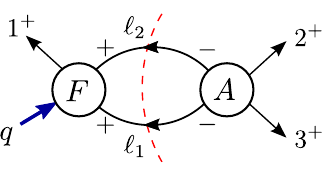
Figure 1 . A two-particle cut of the one-loop minimal form factor of O S or O C